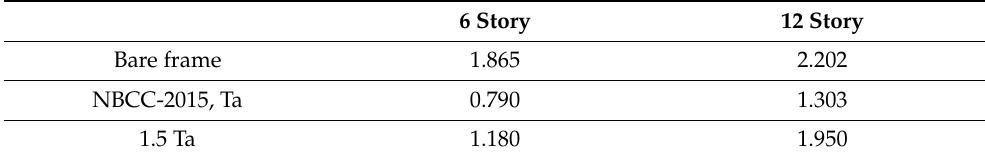
Table 11. Fundamental period (sec).